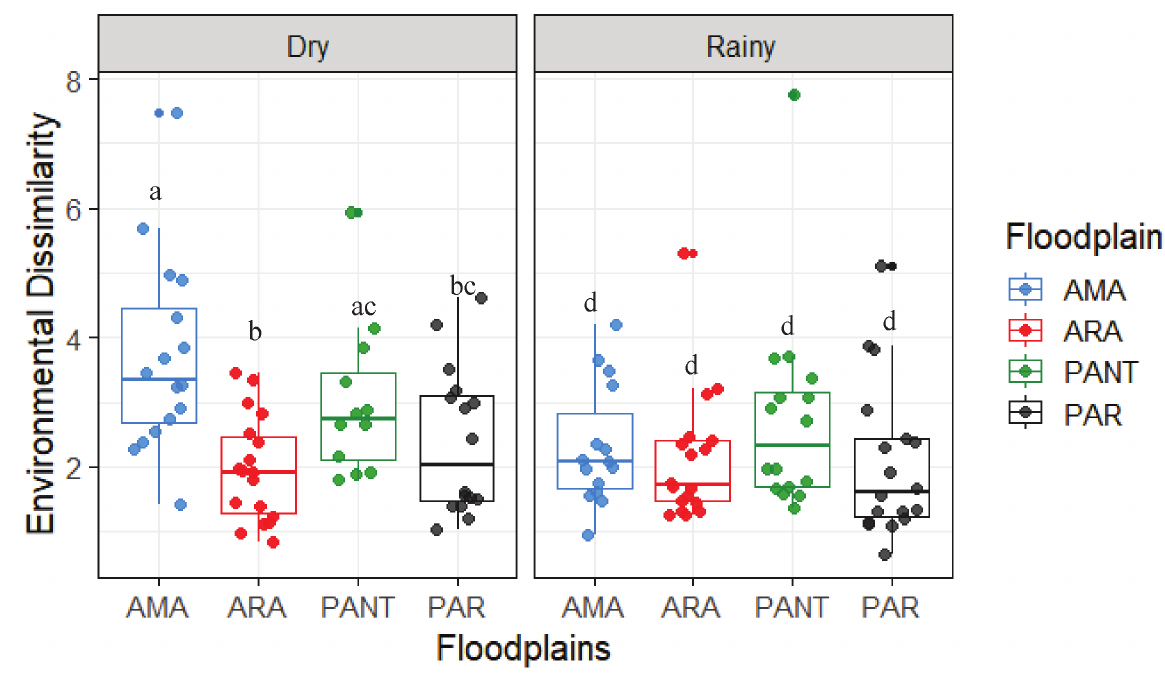
Figure 2. Limnological heterogeneity generated by the PERMIDISP analyses for both hydrologic periods (dry and rainy), in each floodplain. AMA = Amazon, ARA = Araguaia, PANT = Pantanal, PAR = Upper Paraná. The central lines denote the median value, box denotes 25th and 75th percentiles, whiskers represent respectively the smallest and largest value within 1.5 times in interquartile range below and above percentiles, and dots are the observed values. Letters above the columns indicate significant differences in posthoc analyses - floodplains that share a letter do not differ significantly, p <